Question: Describe this figure in one sentence.
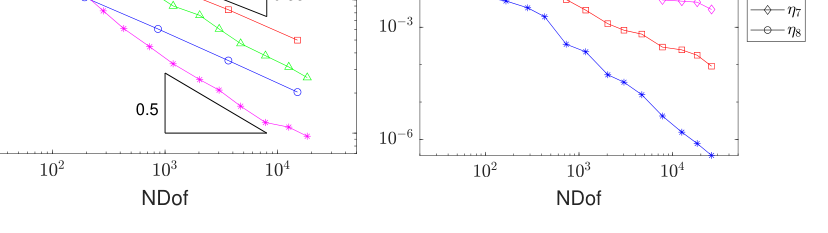
Answer: Left panel displays NDof vs error in energy norm and estimator in both uniform and adaptive reﬁnements, and right panel displays estimator components in adaptive reﬁnement for nonconforming VEM.